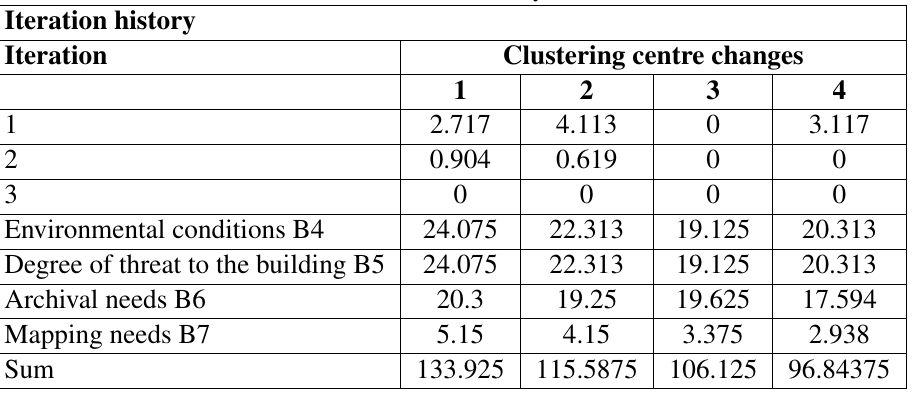
Table 2 Iteration history